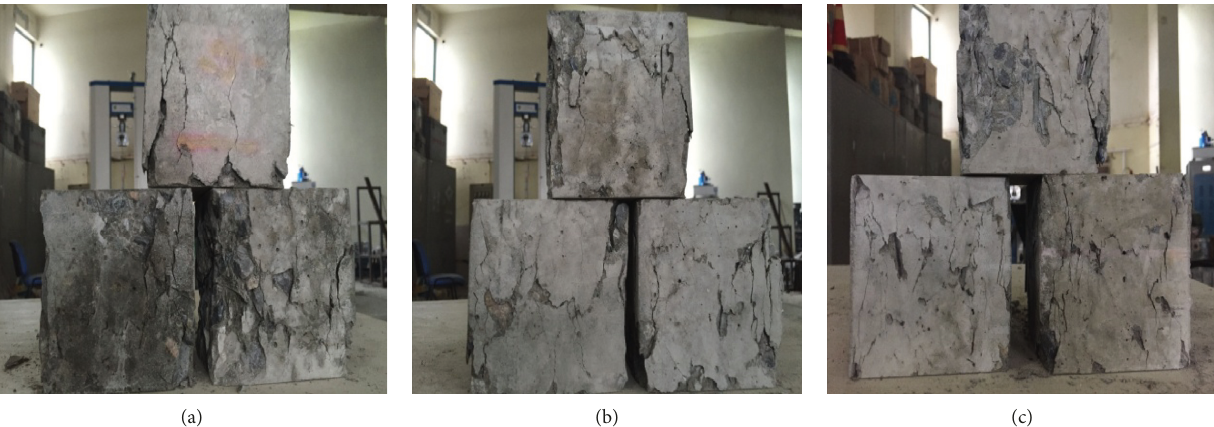
Figure 5: Failure patterns of cubic specimens of directionally distributed SFRC under (parallel) compressive loading. (a) 0.4%; (b) 0.8%; (c)